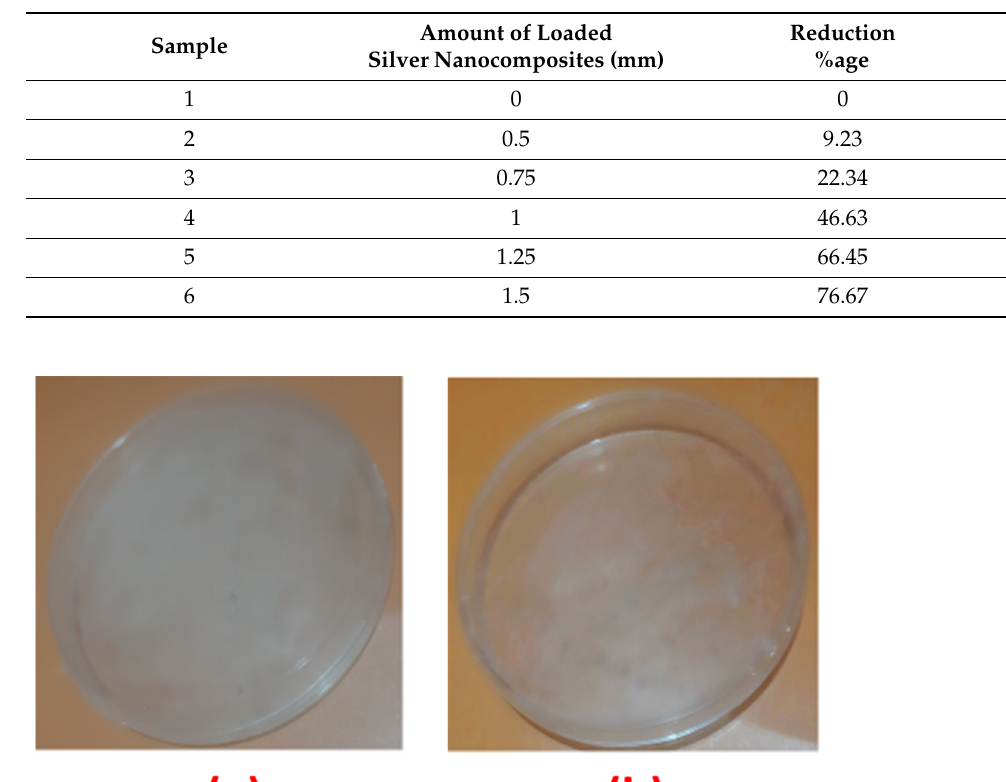
Table 5. Reduction percentage of fungal activity.